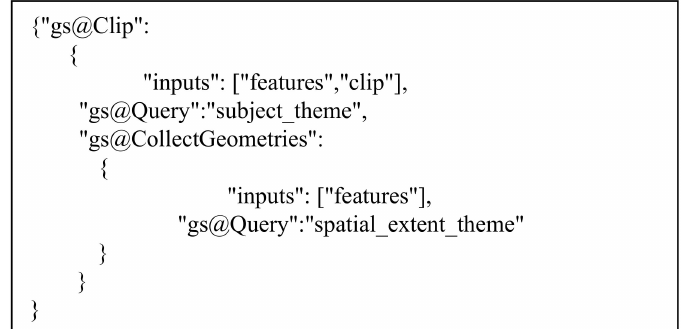
Figure 5. An example of rule definition for the clip operation in JSON